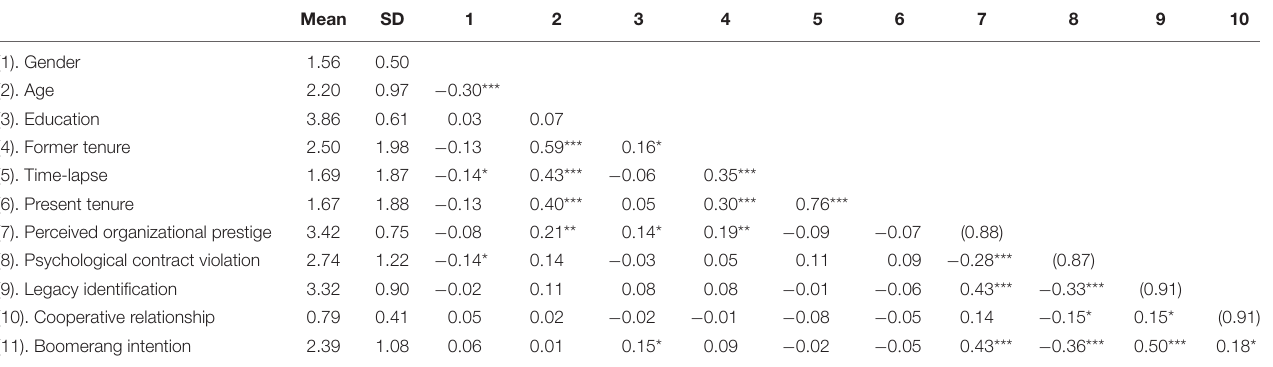
TABLE 2 | Means, standard deviations, and intercorrelations.